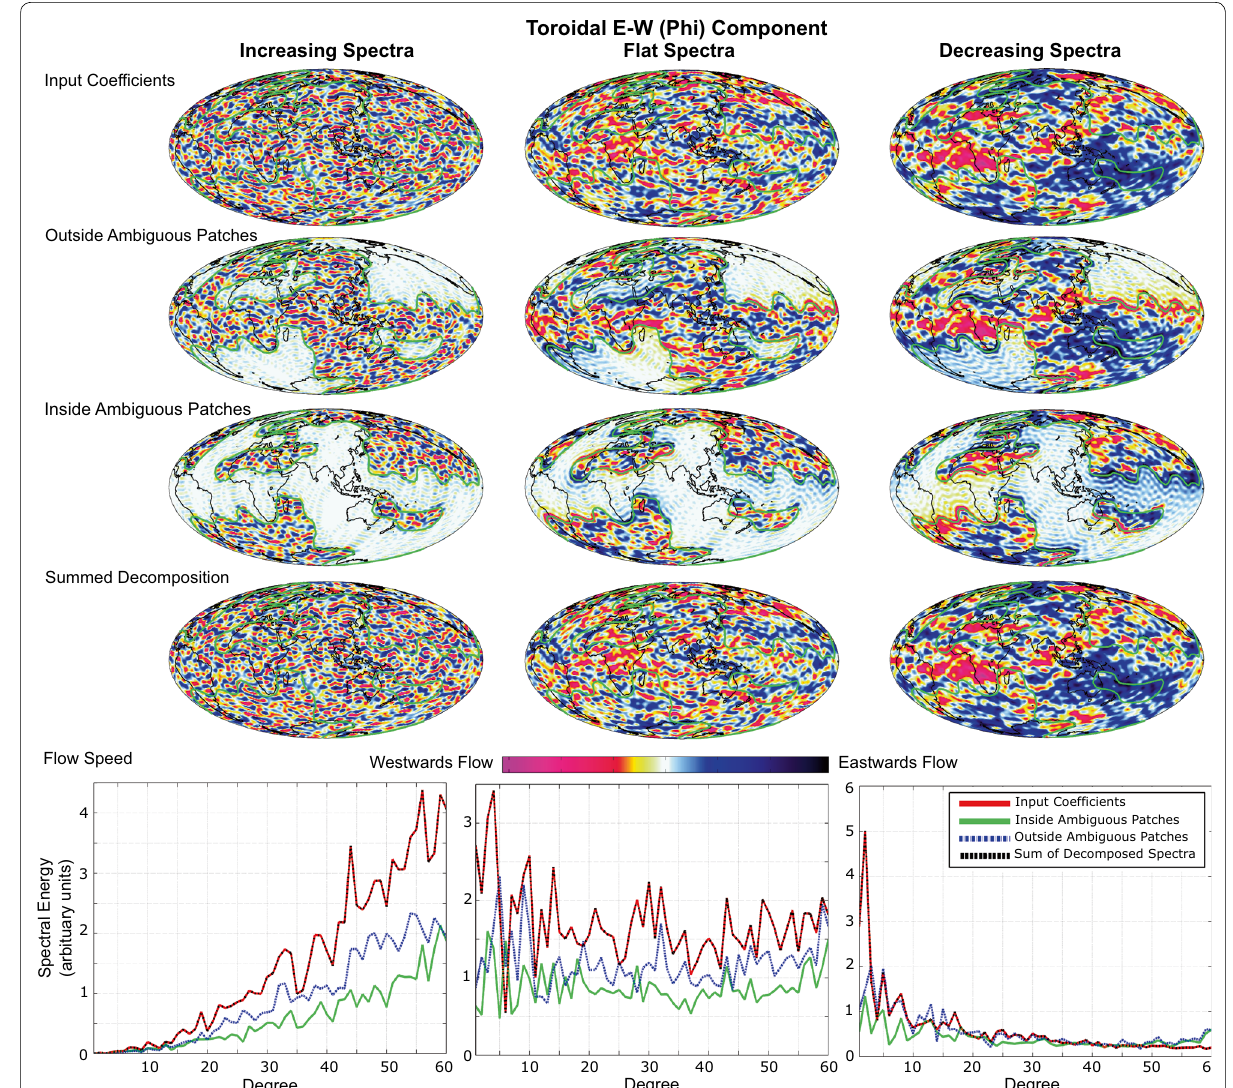
Fig. 3 Decomposition of three synthetic spectra. Three synthetic flow models, with different energy spectra, decomposed using the Shannon 1504 ) for the ambiguous patches. The top row (left: increasing; middle: flat; right: decreasing) shows maps of the azimuthal ( u φ ) number ( K = component of the toroidal flow. The second and third rows illustrate the spatial decomposition. The fourth row shows the summation of the decomposed parts of the flow model, which matches the first row. The bottom row shows the spectral decomposition. Note the different magnitudes of aliasing along the boundaries of each separated region depending on shape of